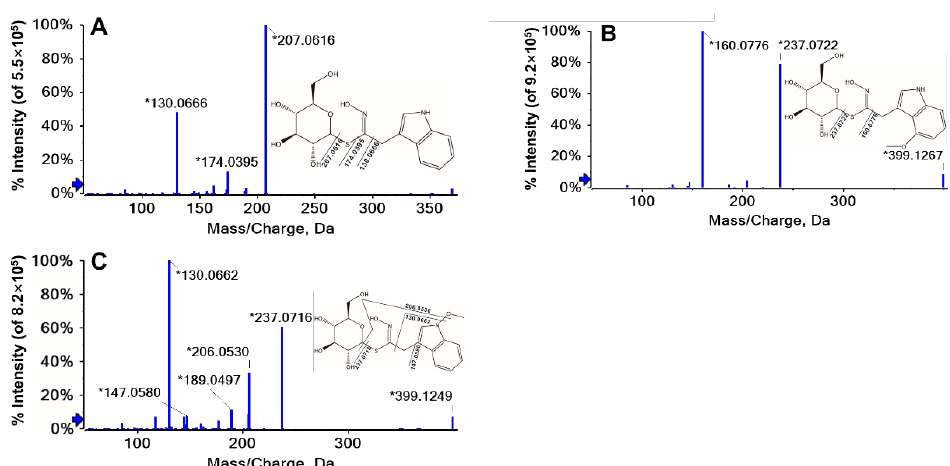
Figure 2. LC – MS/MS spectra of indole glucosinolates and their chemical structures in broccoli. ( A ), Glucobrassicin (GBS); ( B ), 4-Methoxyglucobrassicin (4MGBS); ( C ), Neoglucobrassicin (NGBS). The * sign indicates that this fragment ion is generated by this molecular ion peak, which is judged by the liquid mass software.